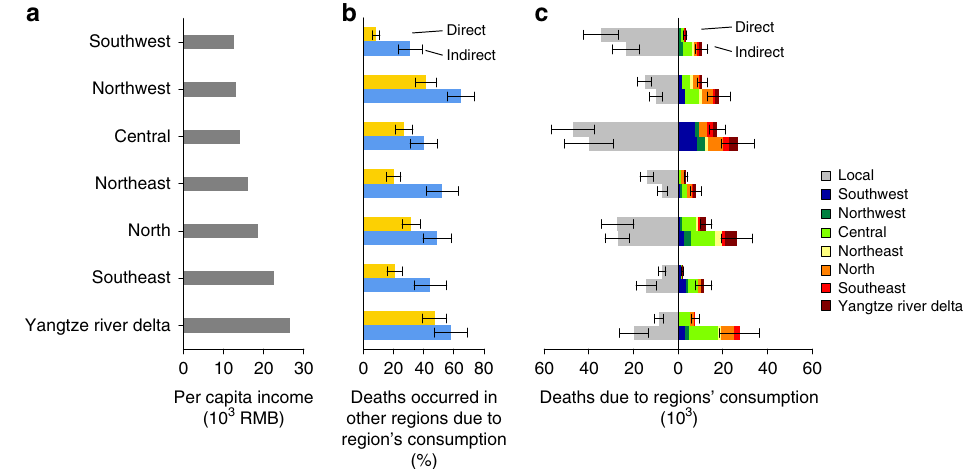
Fig. 4 Premature deaths related to consumption in seven regions of China. a Per capita income of seven regions. b Ratio of deaths occurred in other regions due to each region ’ s direct (yellow) and indirect (blue) consumption. c Regional household consumption related deaths and where the deaths occurred. For panel ( c ), the gray bar extend to the left means deaths occurred locally and the colored bar extend to the right means the deaths occurred in other regions. Error bars in panels ( b ) and ( c ) present uncertainty ranges (95% CI) of the estimates. Source data are provided as a Source Data fi